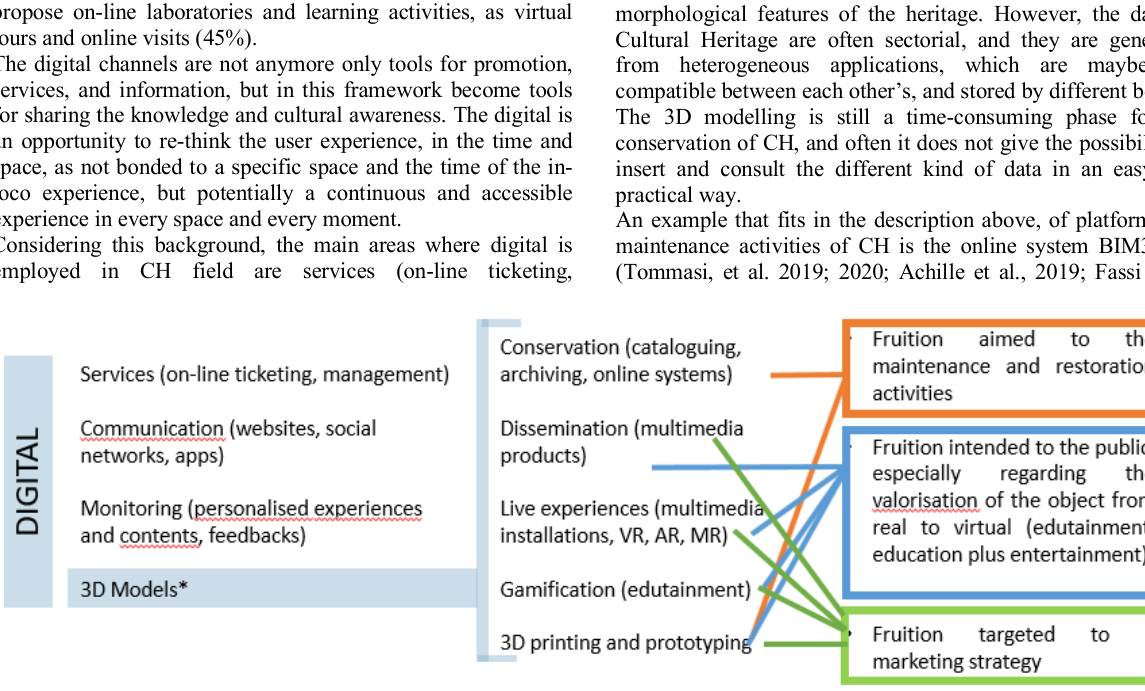
Figure 1 . The usage of 3 models in CH Field, and how these products can be accessed by different users, according to the purpose of the